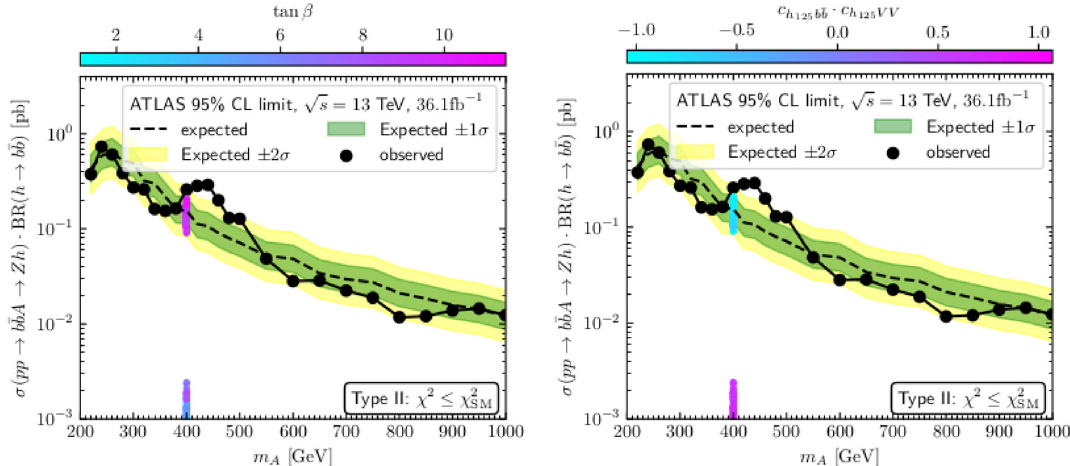
Fig. 5 Predicted rate for σ( b ¯ b → A → Zh 125 ) × BR ( h 125 → b ¯ b ) in comparison with the expected and observed 95% confidence level upper limits obtained by ATLAS [8]. The colors of the points indicate the value of tan β (left) and the value of the product c